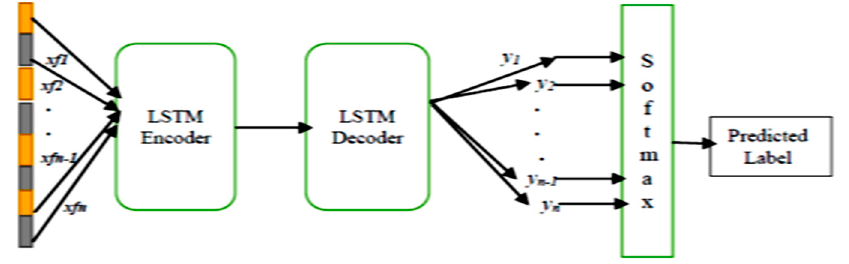
Figure 6. The framework of LSTM (Encoder-Decoder).